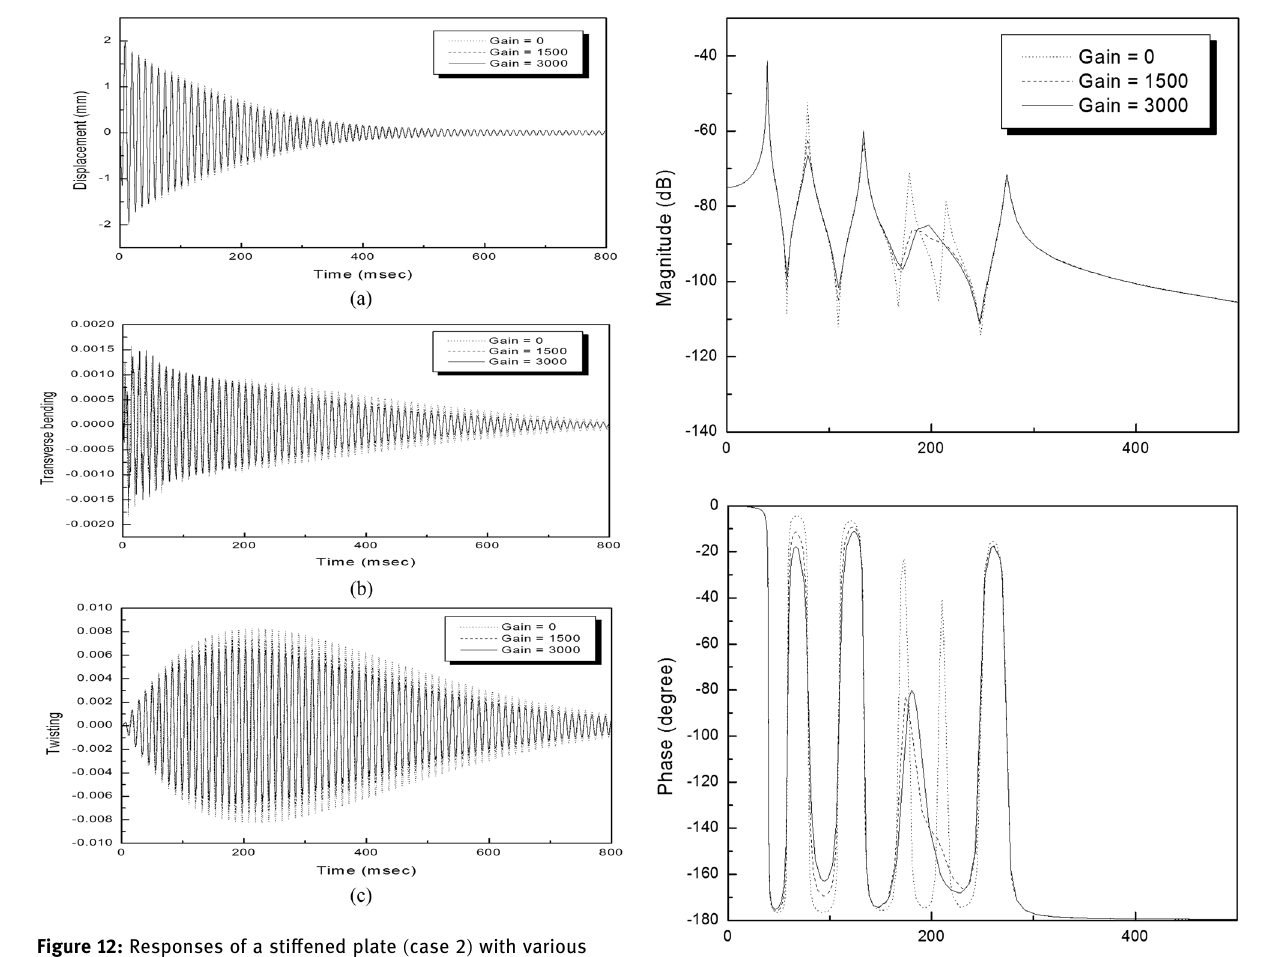
Figure 12: Responses of a sti ff ened plate ( case 2 ) with various control gains: ( a ) vertical displacement, ( b ) transverse bending displacement and ( c ) lateral twisting displacement.